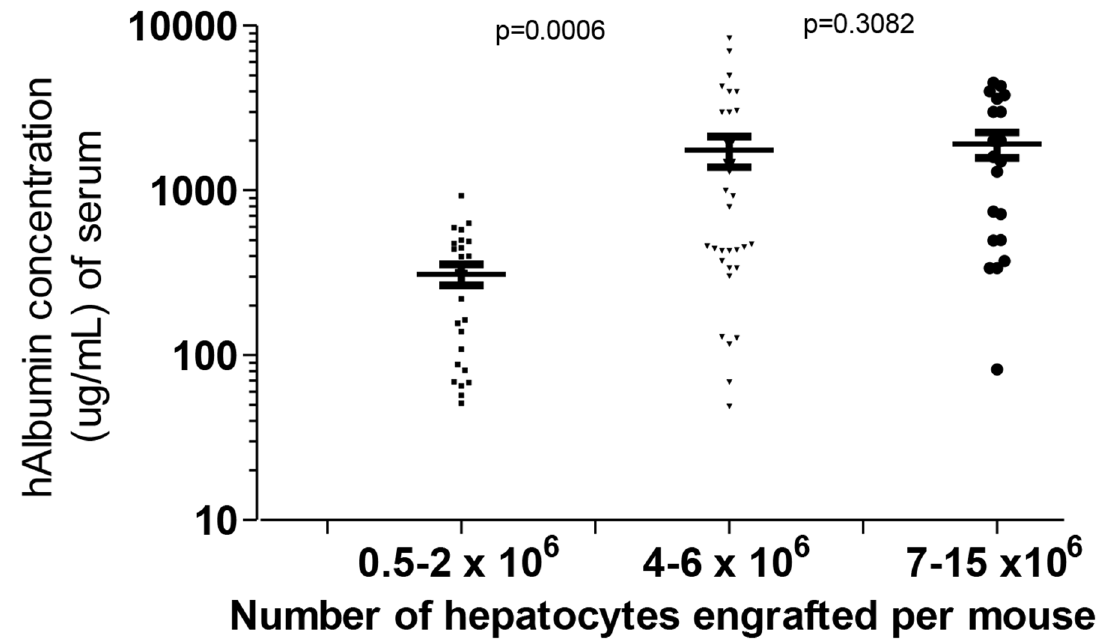
Figure 2. The number of human hepatocytes needed for optimum engraftment was determined by the level of human albumin secretion in the cells. Plots represent the mean human albumin concentration and interquartile ranges of human albumin levels (ug/mL) in the serum of MUP-uPA-SCID/Bg mice transplanted with different numbers of human hepatocytes (n=25, 310 ug/mL +45, n=31, 1.75 mg/mL +365, n=20, 1.8 mg/mL +339).